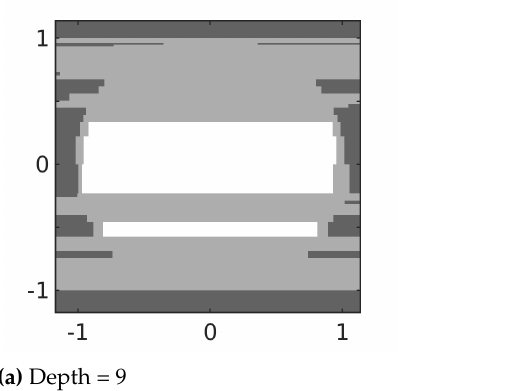
Figure 3. The polygons generated by MTRE − PAN for the circle function f with a radius of 1 when the maximum tree depth is set to ( a ) 9 and ( b ) 12. The dark and white-shaded polygons define the boundaries of the negative and positive samples, respectively. The medium shaded polygons represent uncertain regions.